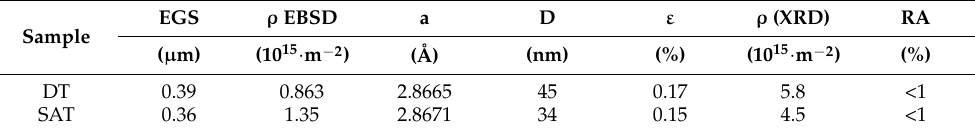
Table 3. Summary of EBSD and XRD analyses results: effective grain size (EGS) and dislocation density ( ρ EBSD) determined by EBSD analysis and lattice parameter (a), crystallite size (D), mi- crostrain ( ε ), dislocation density ( ρ (XRD)), and amount of retained austenite (RA) determined by XRD